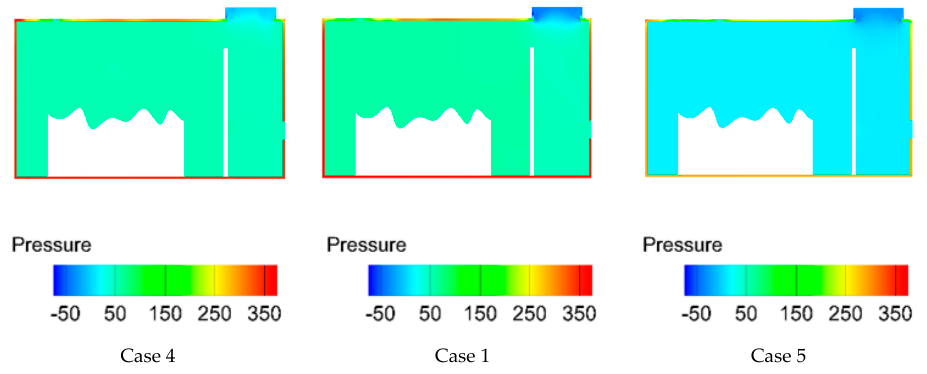
Figure 13. Total pressure inside the incinerator for the place of installation of the primary burner (kPa).